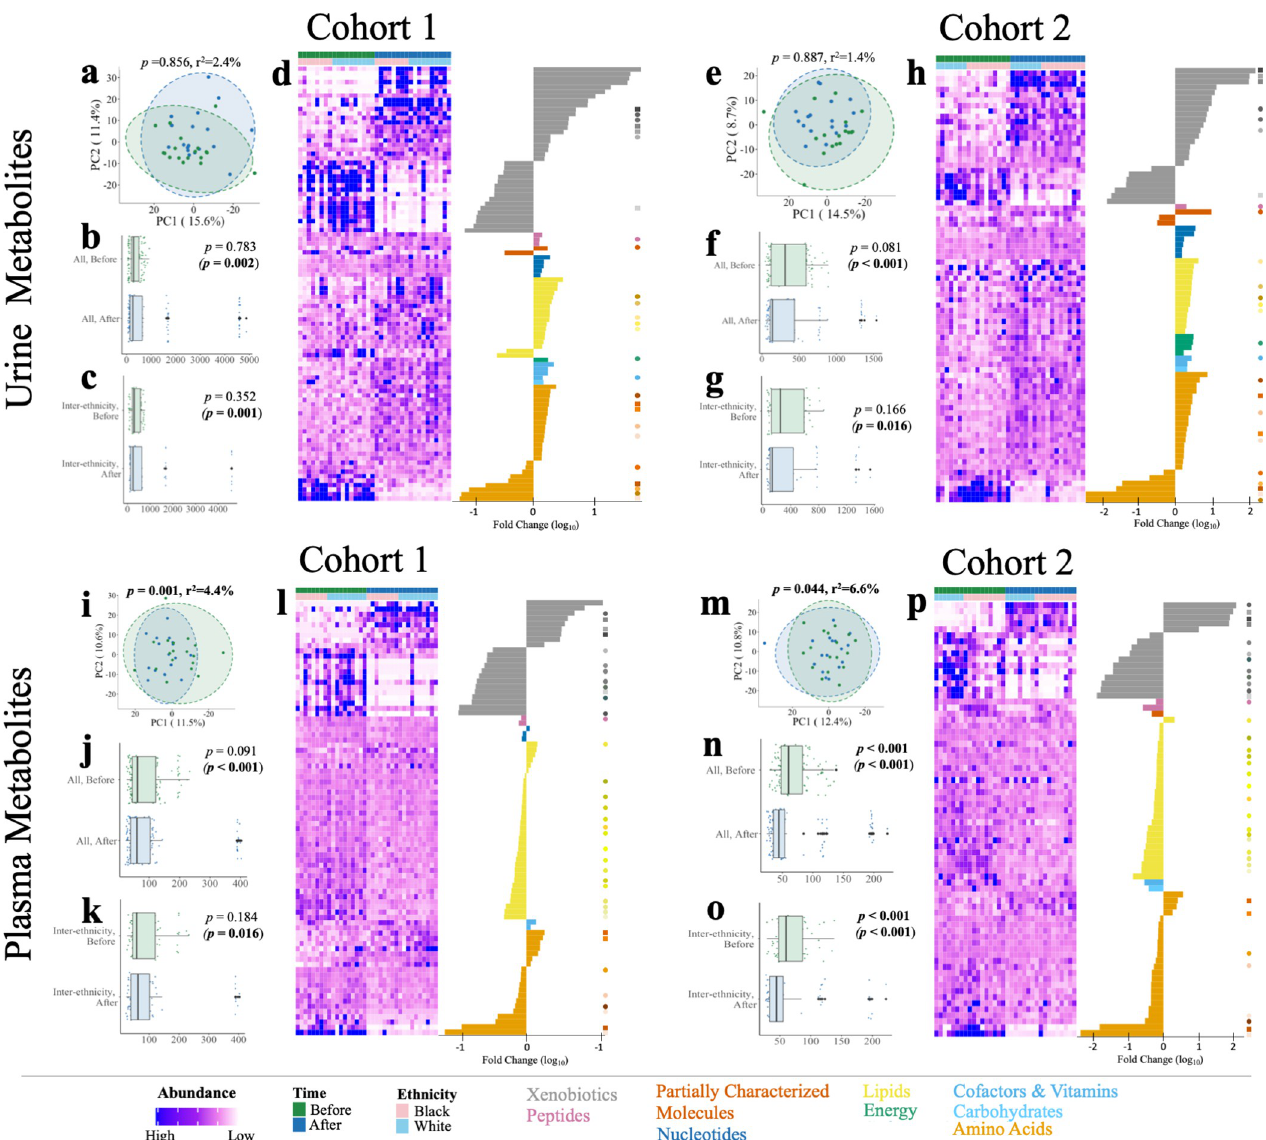
Fig 5. Dietary intervention alters urine and plasma metabolomes. Univariate analysis on metabolomic samples before and after a short-term diet identified 180 significantly changed total metabolites in cohort 1 and 152 metabolites in cohort 2 ( P FDR < 0.05, Wilcoxon signed-rank test). Total urine metabolome compositions were not significantly different between diet stages or ethnicities in either cohort (A, E) ( P FDR < 0.05, PERMANOVA). In cohort 1, 97/842 urine metabolites (D) significantly changed over the diet period, while in cohort 2, 80/835 urine metabolites (H) significantly changed. Total plasma metabolome compositions were significantly different between diet phases (I, M) in both years ( P FDR < 0.05, PERMANOVA). In cohort 1, 83/796 plasma metabolites (L) significantly changed between diet phases, while in cohort 2, 72/736 plasma metabolites (P) were significantly different. Pairwise Euclidean distance between all participants and interethnic groups significantly changed in urine (B, C, F, G) and plasma (J, K, N, O) across cohorts ( P < 0.05, Wilcoxon rank-sum test). Statistics in parentheses denote the removal of outlier participants (see Materials and methods, Metabolomics analysis ) . Individual scaled abundances are shown above by stage and by ethnicity and ordered by super pathway. Heatmaps reflect all significantly changed metabolites within cohort-matched, color- coded dots and ordered by decreasing log 10-fold change within each super pathway. Circles denote metabolites significant in both cohorts; squares represent metabolites significantly different in both cohorts and in both urine and plasma. Abundance corresponds to scaled and transformed intensity value of each metabolite. A key of ordered metabolites, fold changes, and p -values can be found in S1